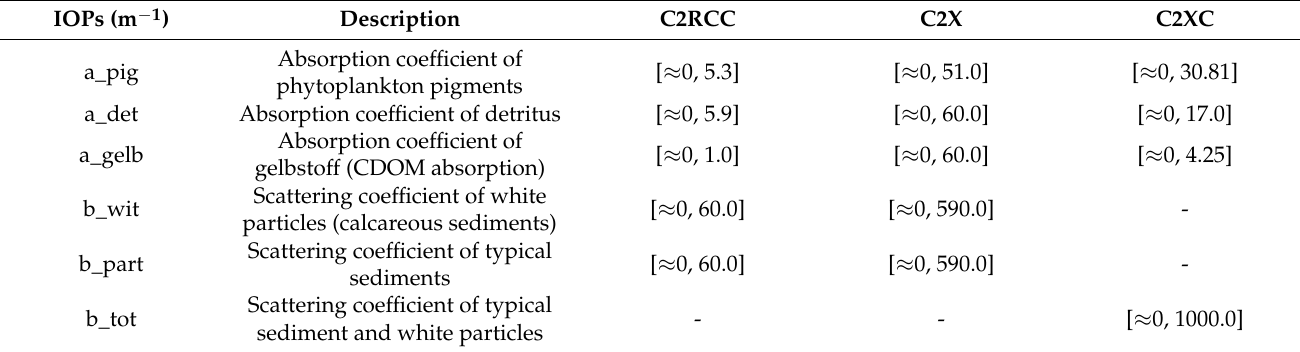
Table 4. IOP training ranges of the C2-Nets